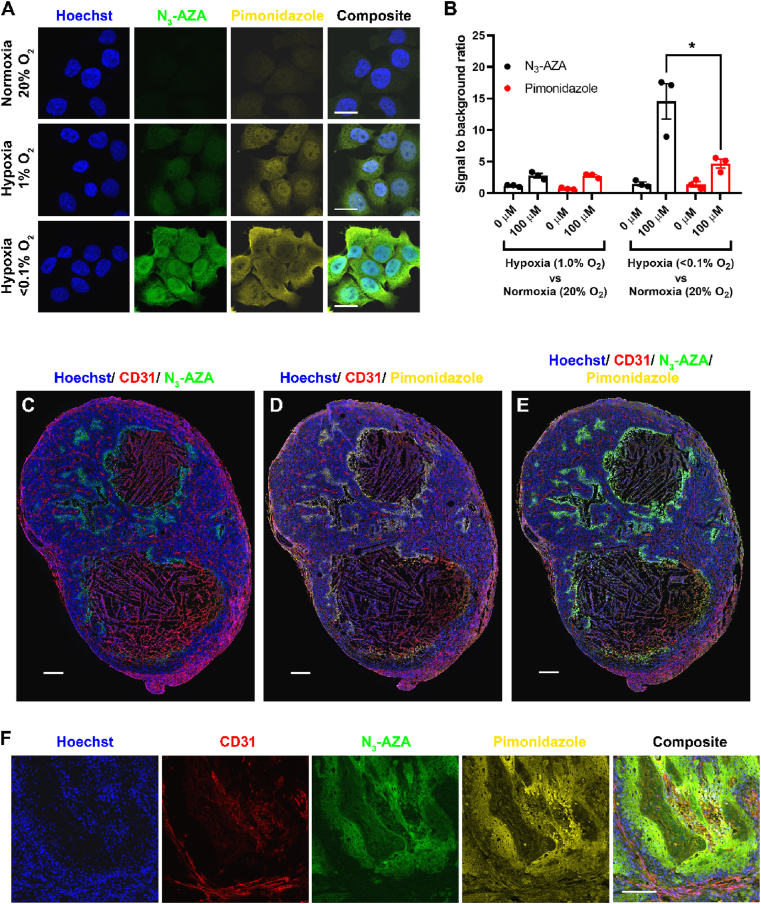
Pimonidazole immunostaining is comparable to that of N3-AZA. (A) Representative micrographs from three independent experiments showing that N3-AZA click staining and pimonidazole immunostaining overlaps in hypoxic FaDu cells co-treated with both compounds. (B) The micrographs were processed with IMARIS software to quantify channel intensities from N3-AZA click staining and pimonidazole immunostaining. The ratios of signal (hypoxia):background (normoxia) intensities for cells co-treated with N3-AZA and pimonidazole [or vehicle control (0.02% DMSO) i.e. columns labelled 0 μM, see Fig. S7 for micrographs of cells not treated with N3-AZA or pimonidazole] are shown (mean ± S.E.M.). N3-AZA click staining generated a higher signal to noise ratio compared to pimonidazole immunostaining. (C–F) In vivo comparison of N3-AZA click staining with pimonidazole immunostaining. Both are concentrated in the same regions of a mouse subcutaneous tumour section (C–E) and of a primary mouse head and neck tumour section (F). Representative micrographs are displayed from at least three independent experiments; scale bar represents 20 μm (A), 1 mm (C–E) and 200 μm (F).